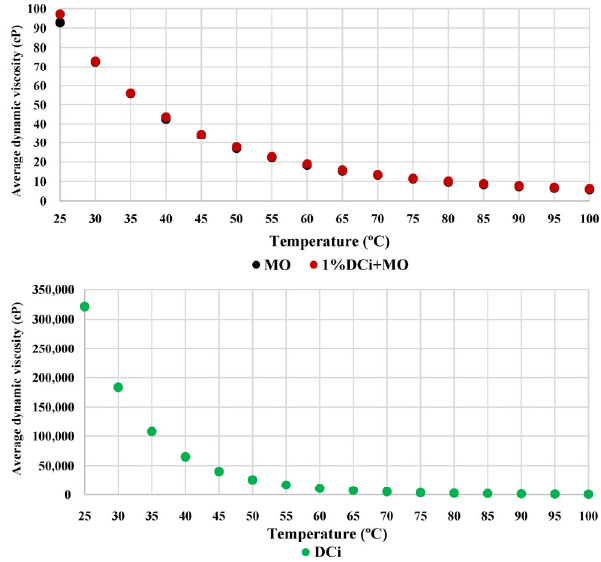
Fig. 5 Viscosity of MO, pure DCi, and mixture 1 wt% DCi+MO. Table 4 Viscosity of MO, DCi, and 1 wt%